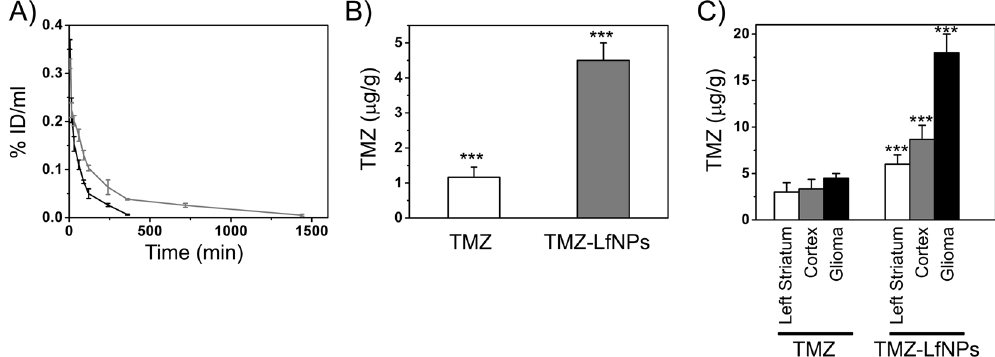
Figure 5. ( A ) Pharmacokinetic studies. % ID/mL of plasma TMZ is plotted versus time after i.v. injection of free TMZ (black) and TMZ-LfNPs (grey) with an equivalent dose of 10 mg kg − 1 of TMZ in C57BL/6 mice. ( B ) Brain uptake of TMZ in healthy mice 24 h post i.v. injection of TMZ and TMZ-LfNPs with an equivalent dose of 10 mg kg − 1 . Sample data were recorded as Mean ± SD, n = 3. *** P < 0.001. (C) Brain uptake of TMZ in glioma bearing mice after i.v. injection of TMZ and TMZ-LfNPs (equivalent dose of 5 mg kg − 1 ). *** P < 0.001.